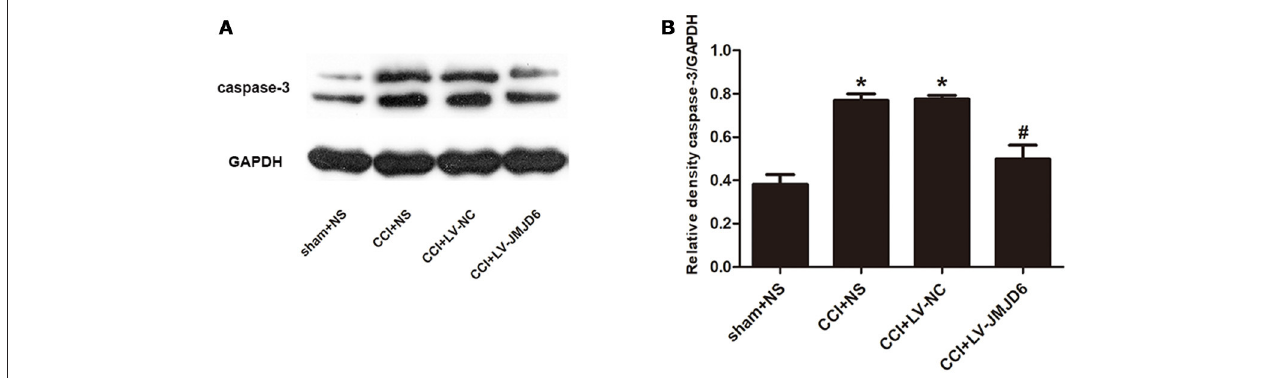
FIGURE 6 | Caspase-3 is decreased in the spinal cord following CCI surgery and intrathecal injection of LV-JMJD6 ( n = 4). (A) Expression of protein Caspase-3 in the lumbar spinal cord in all rats. (B) The mean ( ± SEM) of integrated optical density of Caspase-3/GAPDH in all rats on protein level. * p < 0.05, CCI + LV-JMJD6 vs. sham + NS group; # p < 0.05, CCI + LV-JMJD6 vs. CCI + NS and CCI + LV-NC